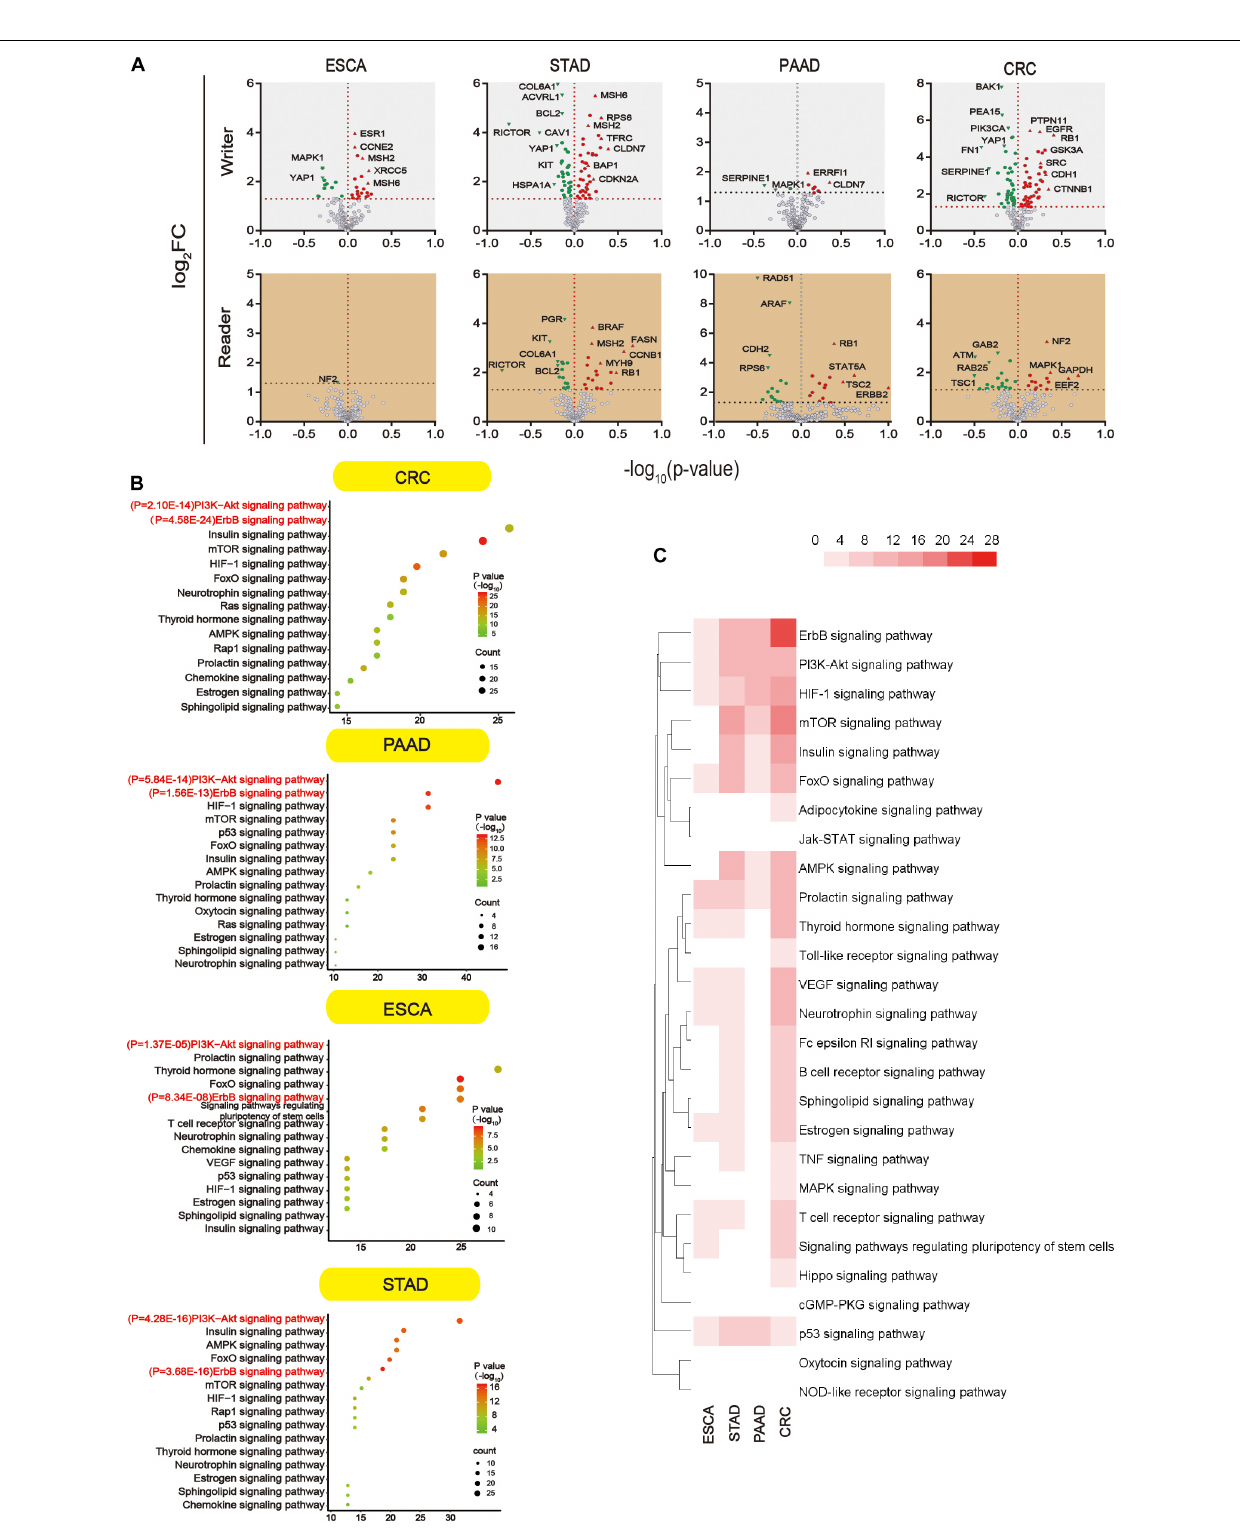
Frontiers in Molecular Biosciences |